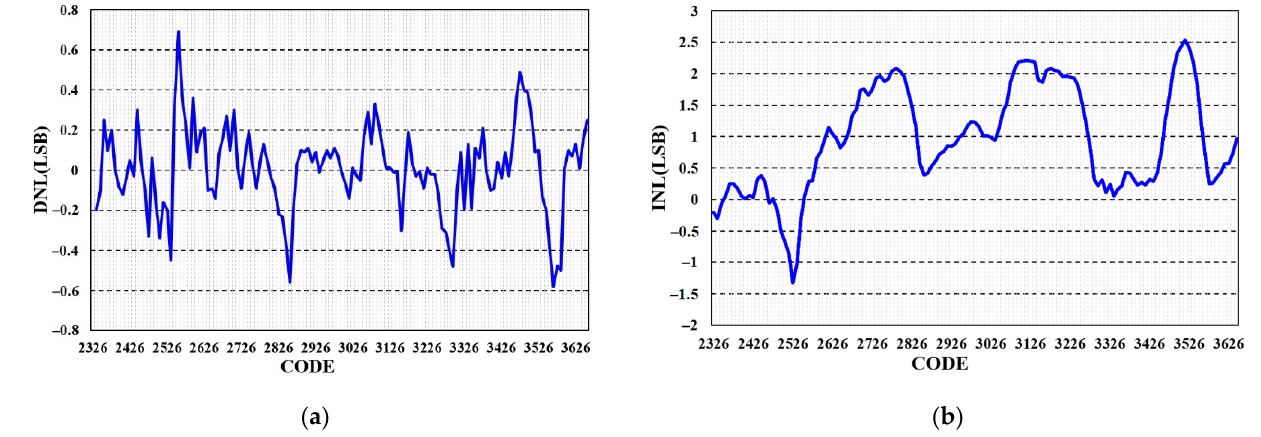
Figure 14. Linearity of the temperature sensor at TT corner: ( a ) DNL; ( b ) INL. The error after one-point calibration is shown in Figure 15a. Matlab ® is used to find the best fitted lines for the five output curves at different corners. At the NMOS-Fast corner and PMOS-Fast corner (FF corner) and SS corner, as shown in Figure 8, the propagation delay of delay unit is proportional and inversely proportional to the temperature respectively, thereby the second order temperature coefficient of the temperature sensor output is positive and negative, respectively. The error curves at the other corner are between those at FF and SS corners. After two-point calibration, the result is shown in Figure 15b. The worst condition occurs at SS corner, which shows an error of 0.9 °C. At the TT corner, the maximum error is less than 0.29 °C. The design parameters used in this work are summarized in Appendix A.